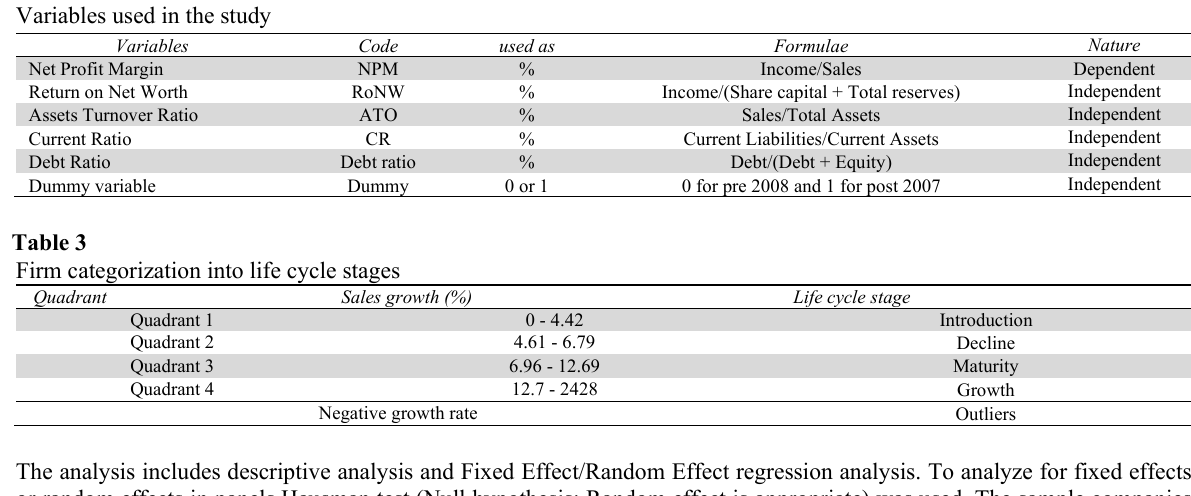
Table 2 indicates the list of sample companies, the age of the sample firms and their average sales growth. Here, the